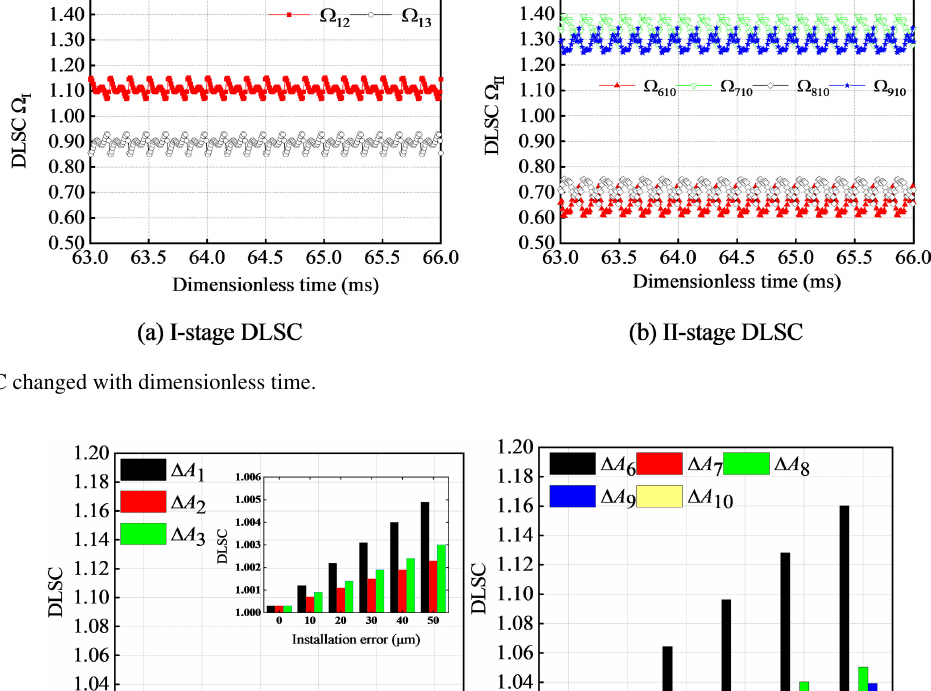
4.78 × 10 6 ) N mm − 1